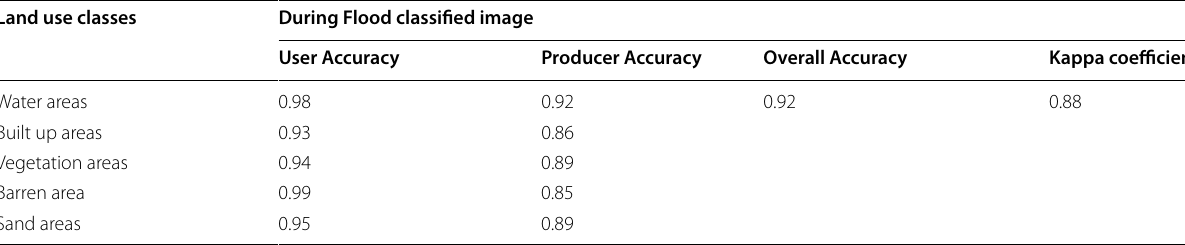
Table 4 Accuracy assessment of during flood Supervised LULC classification Land use